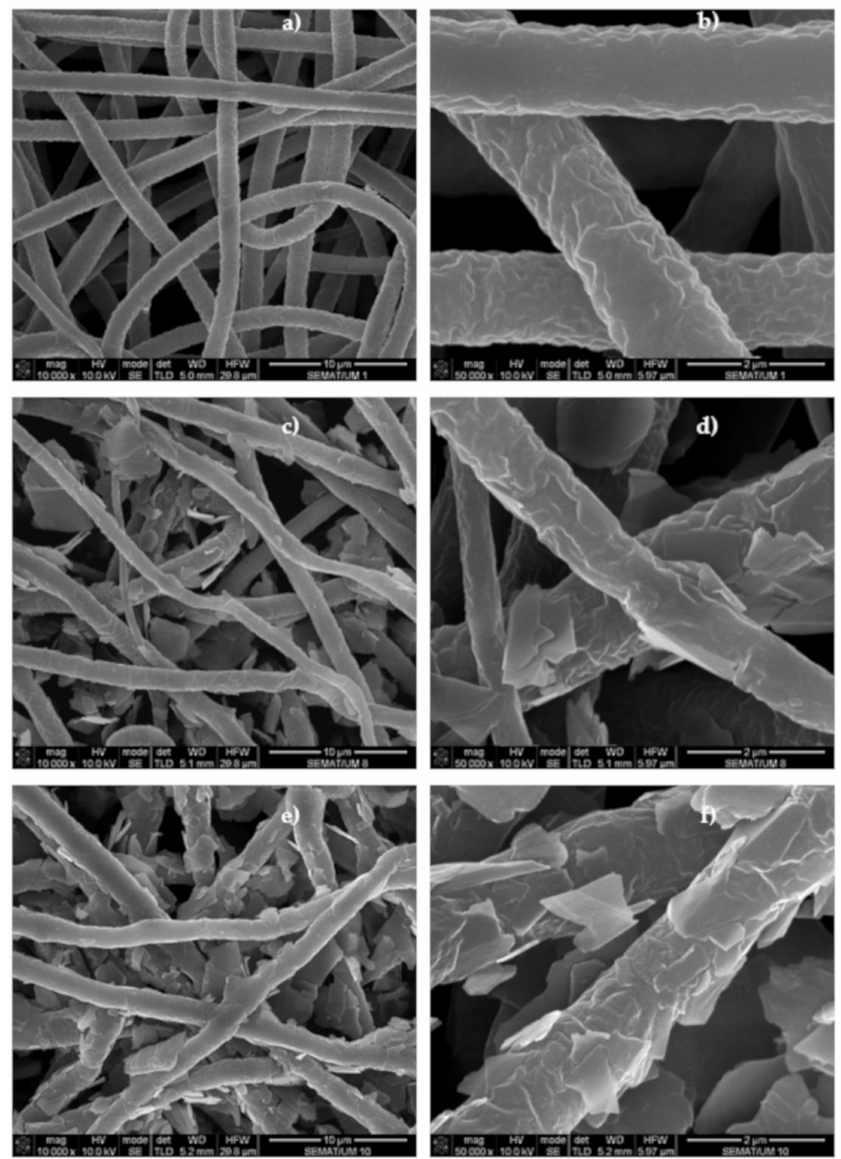
Figure 6. FESEM images of ( a ) and ( b ) PCL microfibers; ( c ) and ( d ) 0.2%GNPs-PCL membranes; ( e ) and ( f ) 2%GNPs-PCL membranes. The magnifications used for these images was of 10,000 × (10 µ m) and 50,000 × (2 µ m), from the left to the